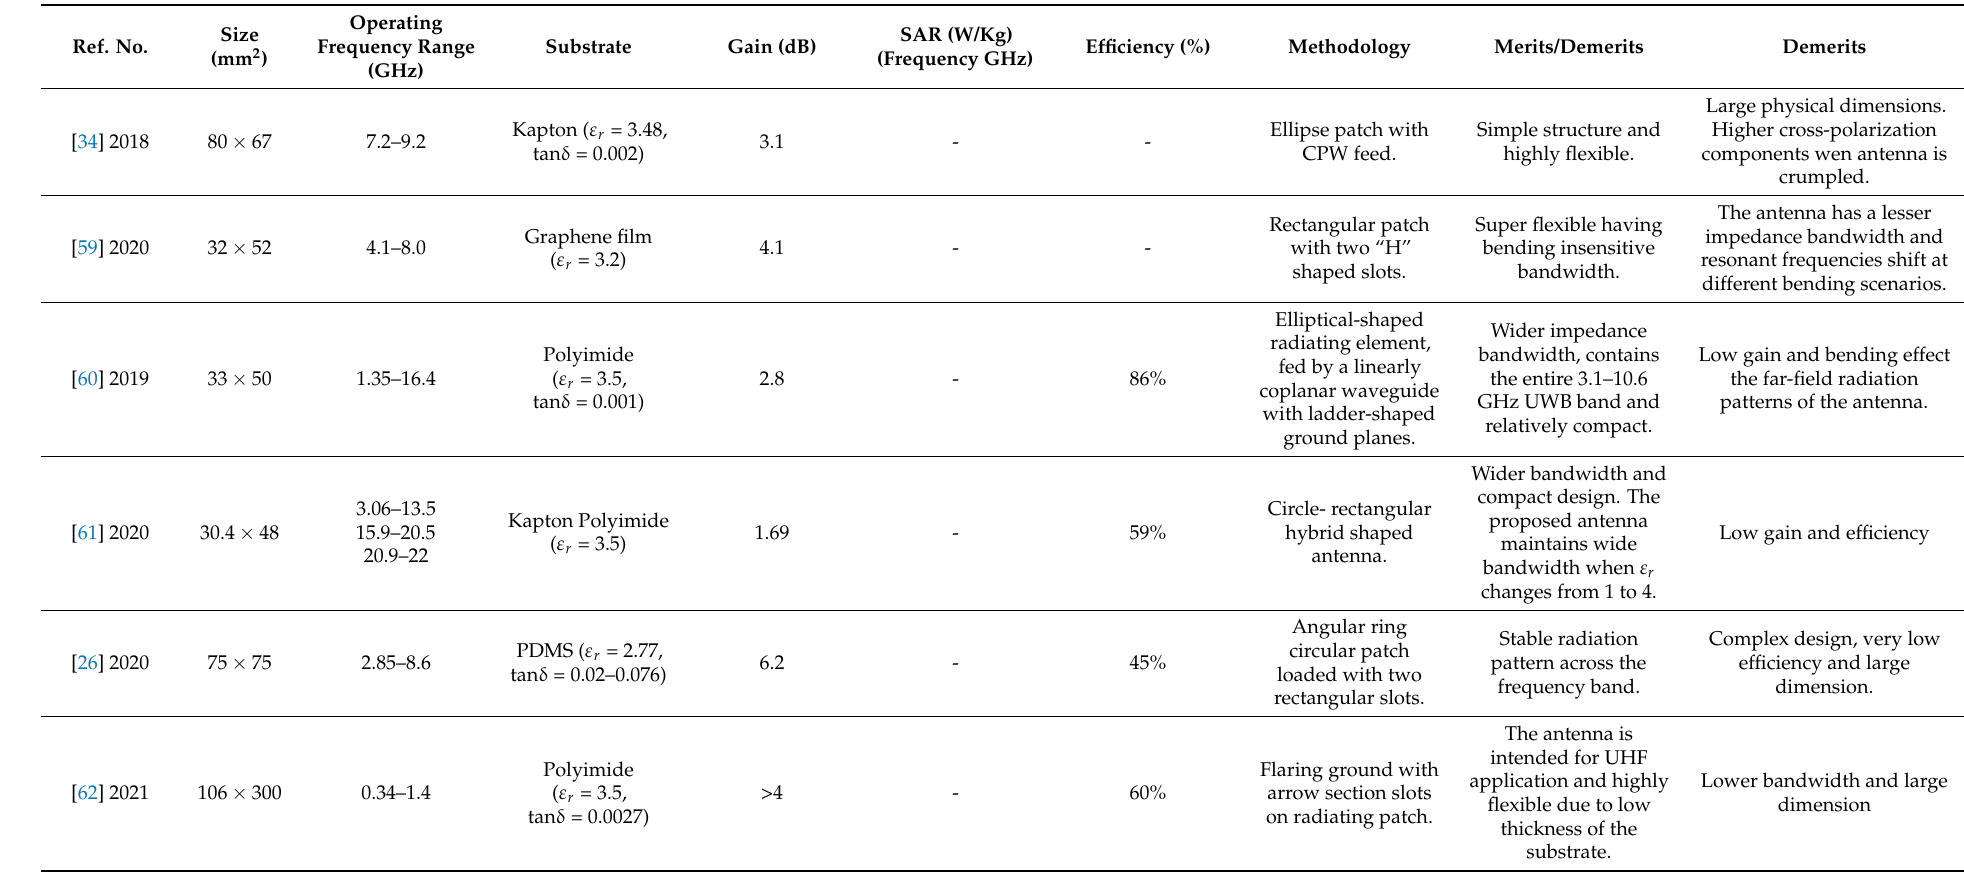
Table 3. Comparison of UWB antennas based on various